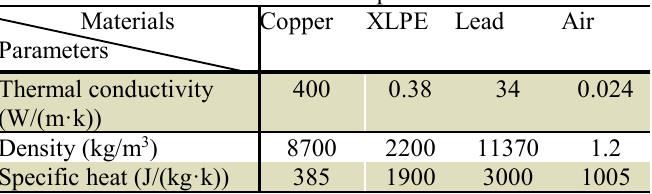
Table 1. Diameters of a power cable